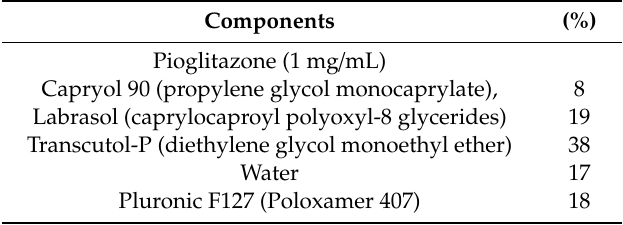
Table 2. Final formulation of pioglitazone-nanoemulsion (PGZ-NE).